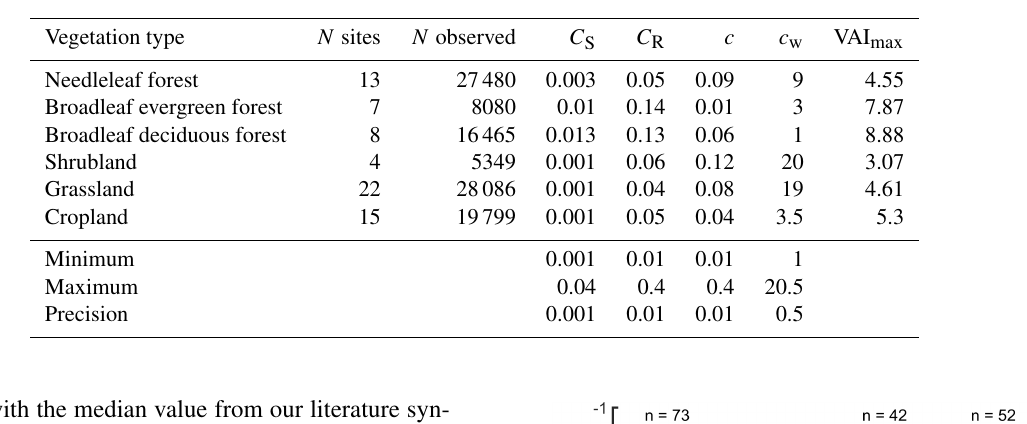
Table 1. Fitted parameter values for Ra92. From left to right, vegetation type, number of sites from Hu20 assigned to this vegetation type, total number of daily z 0 , v estimates used to fit Ra92, and optimized values for C S , C R , c , c w , and the maximum VAI are shown. Below, tested range and precision used when fitting parameters of Ra92 are shown.